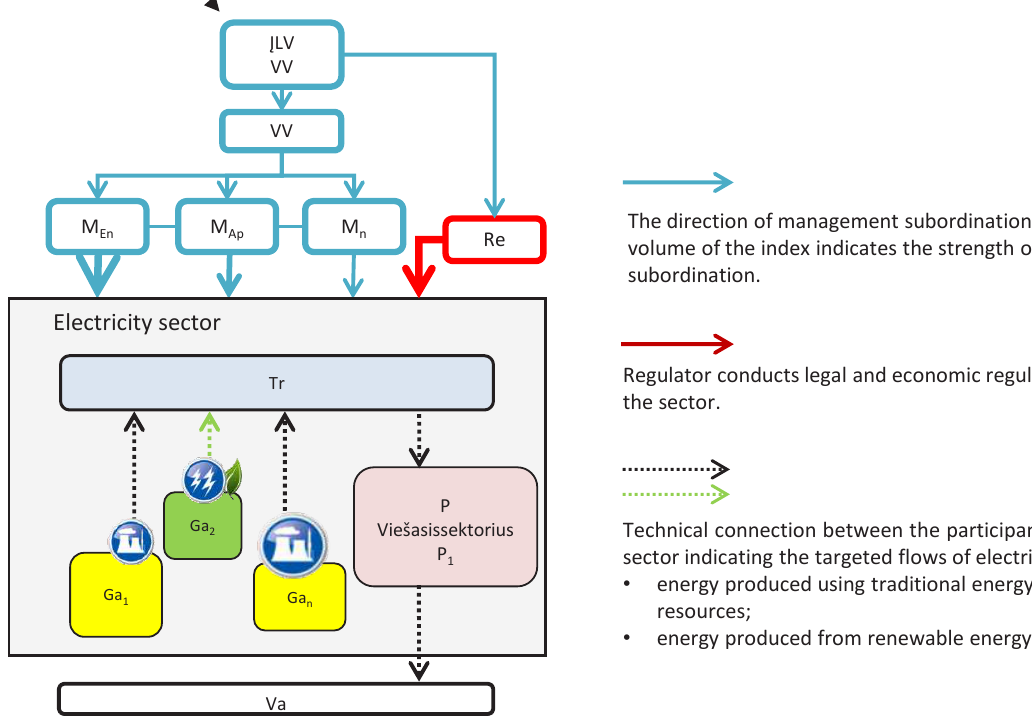
Figure 1. Current model of electricity sector governance in